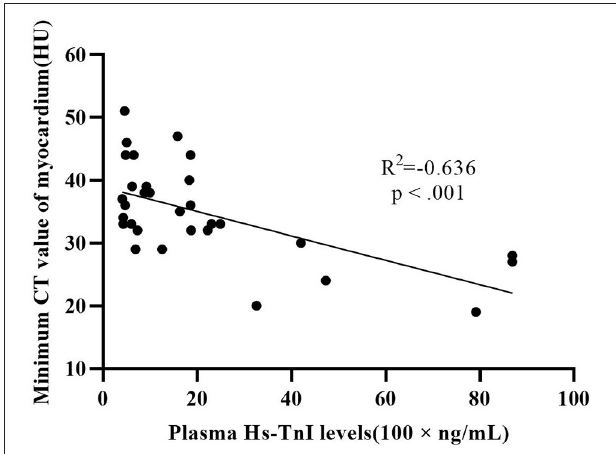
FIGURE 6 | Correlation between plasma hs-TnI and minimum CT value of